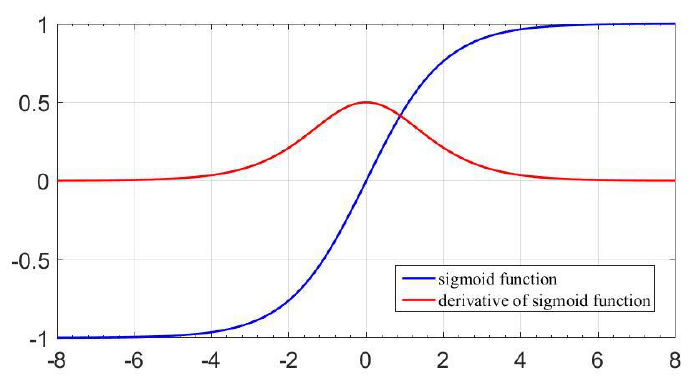
Figure 5. Sigmoid function and derivative of sigmoid function.